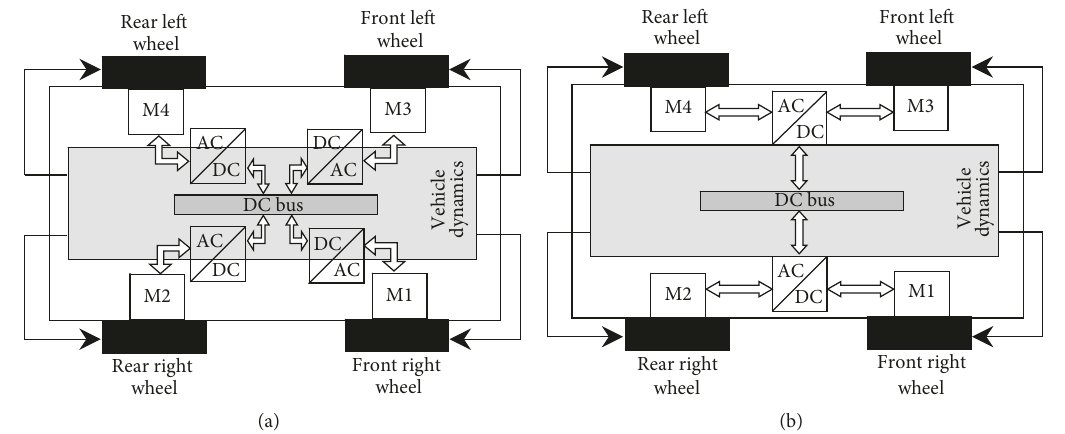
Figure 1: Structure of EV traction with (a) four and (b) two